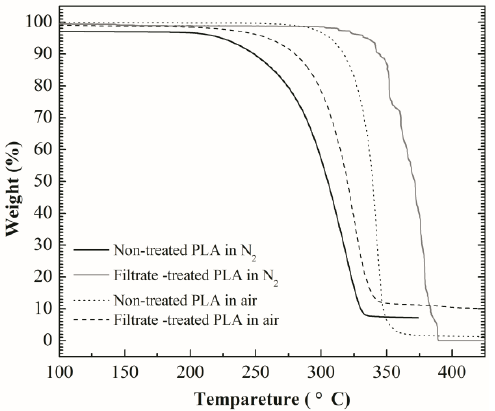
Figure 1. TGA curves for the non- and filtrate-treated PLA.